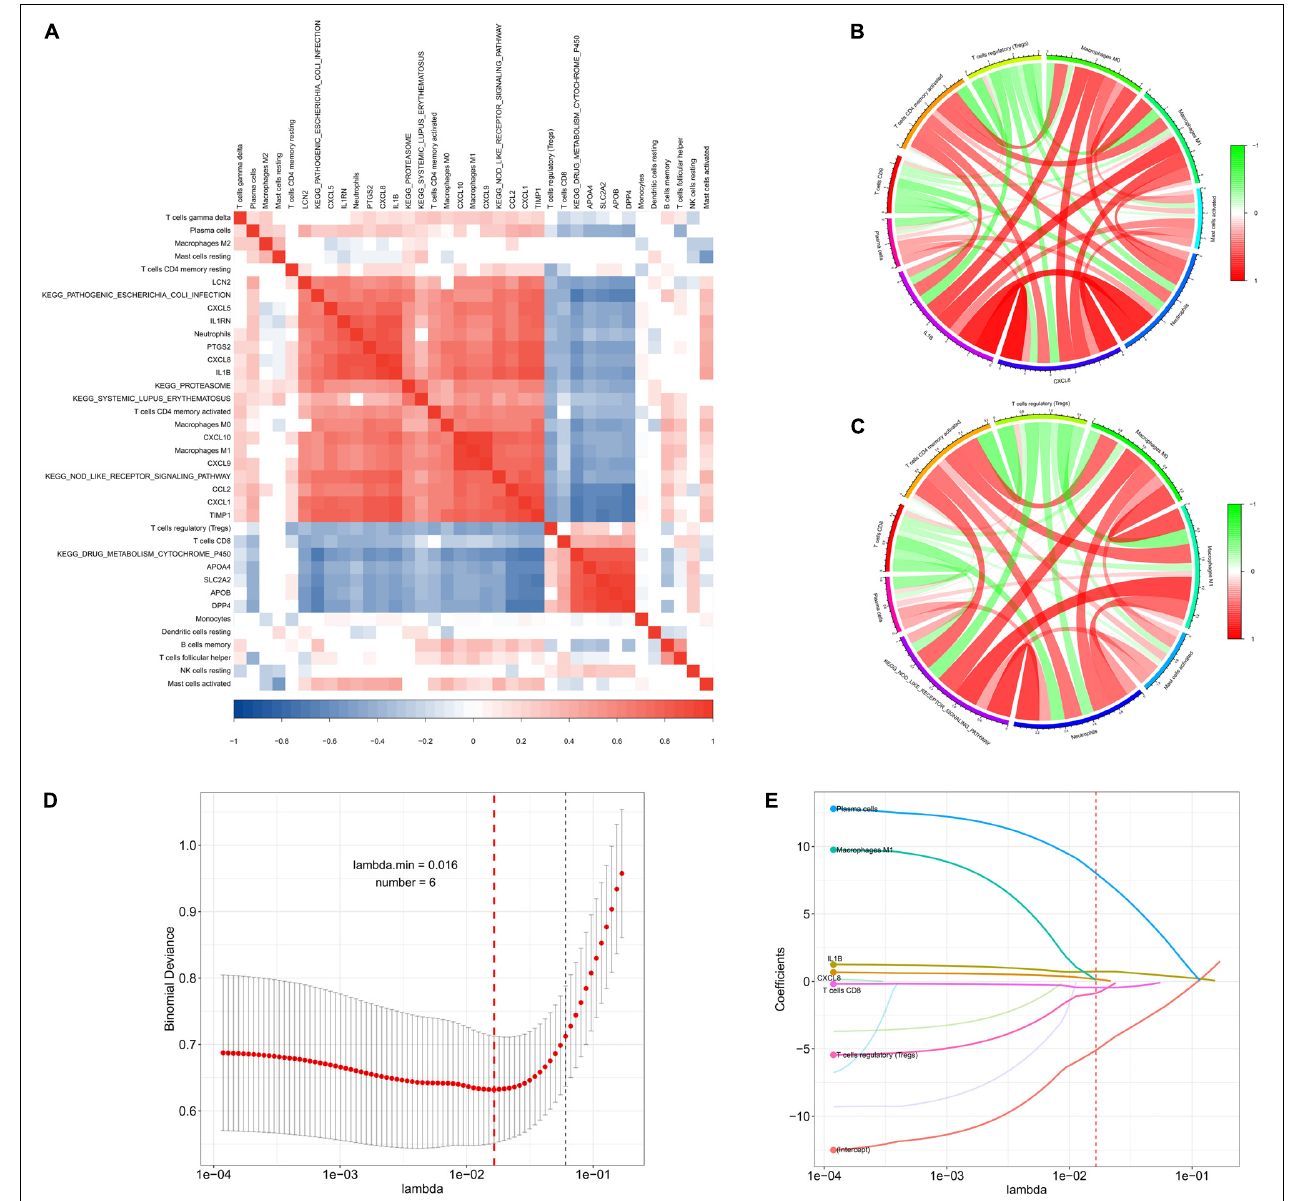
FIGURE 7 | Co-expression patterns and LASSO regression of the derivation cohort. (A) Correlation heatmap showing gene co-expression patterns among significantly altered immune cells, hub genes, and pathways. (B,C) Circos plot showing the relationships between immune cells, CXCL8 and IL1-B levels, and the NOD-like signaling pathway (| correlation coefficient| > 0.3). (D,E) LASSO regression analysis identified six factors with cross-validation performed to prevent